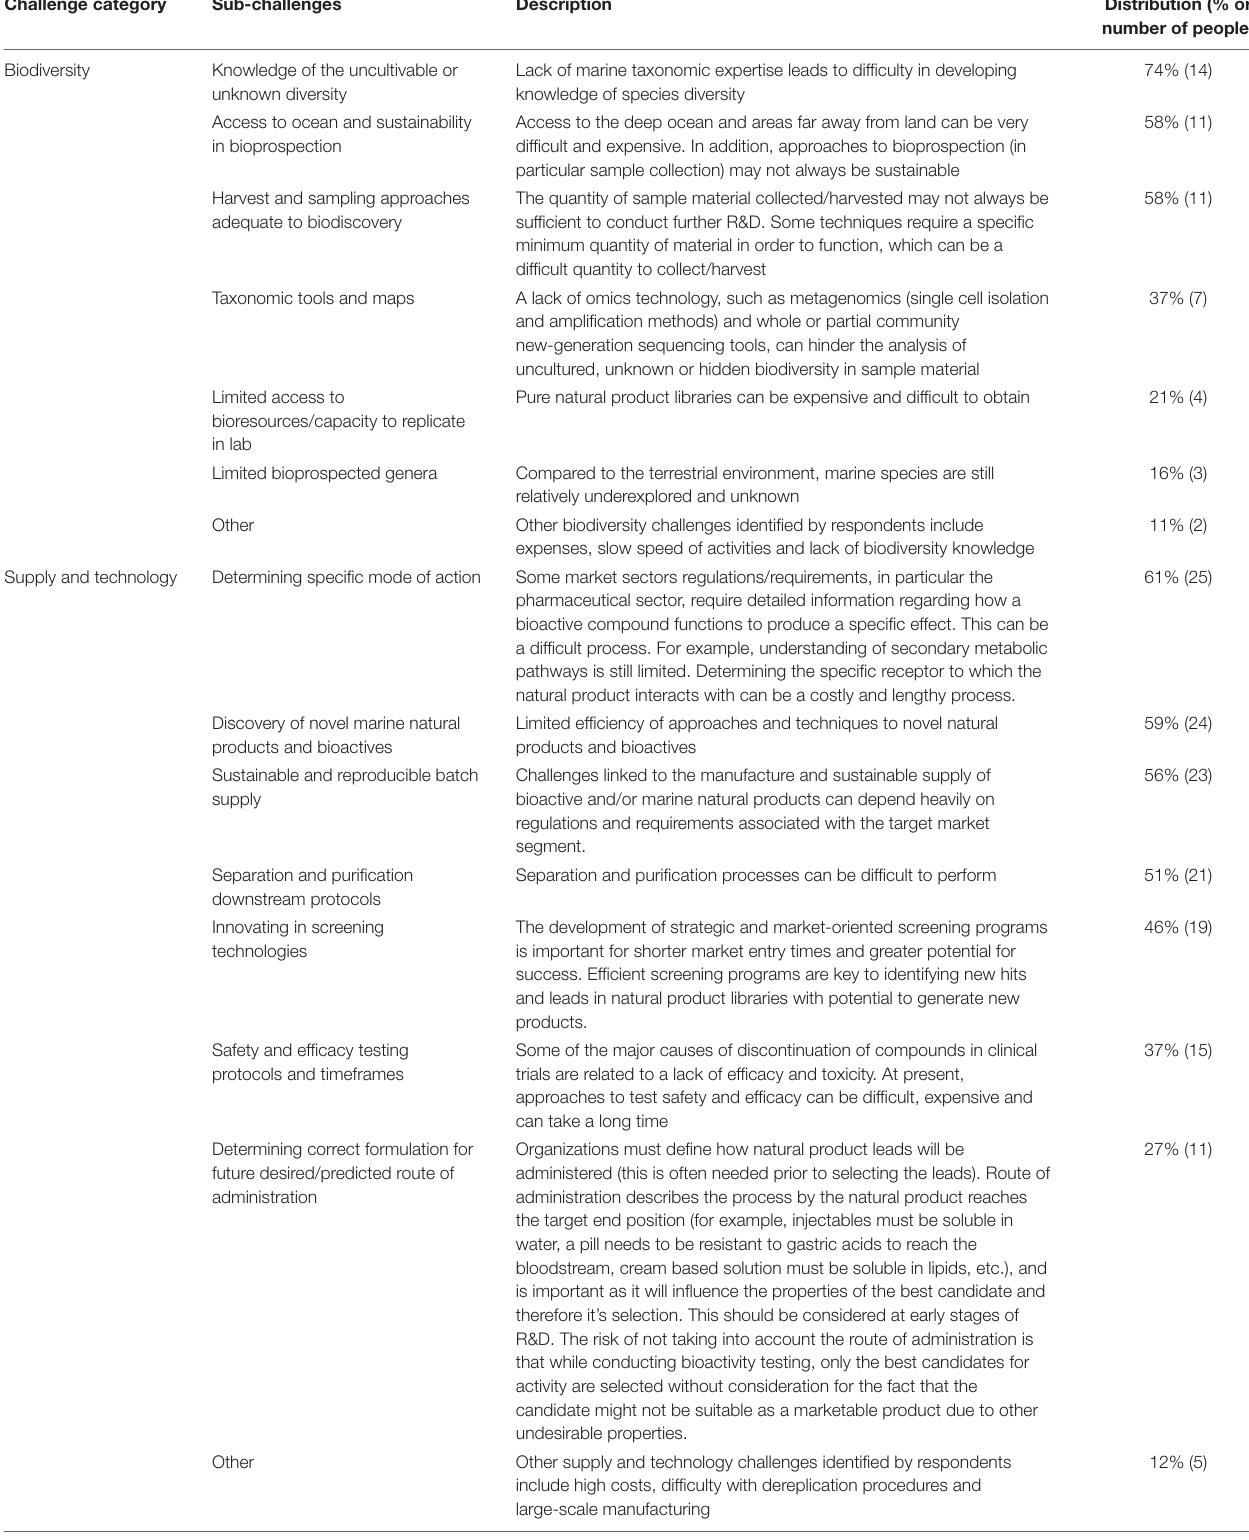
TABLE 1 | Specific sub-challenges experienced by survey respondents related to, biodiversity, supply and technology, and